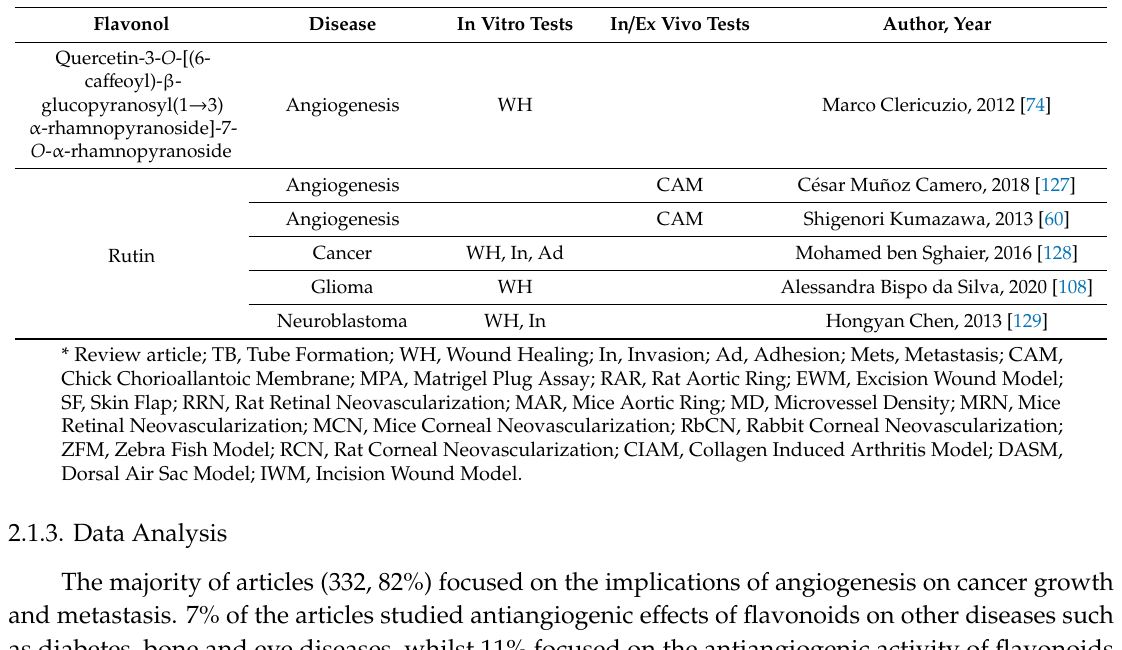
Figure 4. Types of assays used for in vitro and in vivo antiangiogenic evaluation of flavonoids. 2.2. Meta-Analysis 2.2.1. Search Results The second subset search, which is the basis of the meta-analysis forming Section 2 of this study, followed the same general methodology as detailed in the initial overview. 960 records were identified from four electronic databases (381 from ScienceDirect, 496 from PubMed, 65 from Web of Science and 18 from Google Scholar). 25 research articles were finally included in the quantitative analysis after the sequential steps of screening and sifting, as shown in Figure 5.